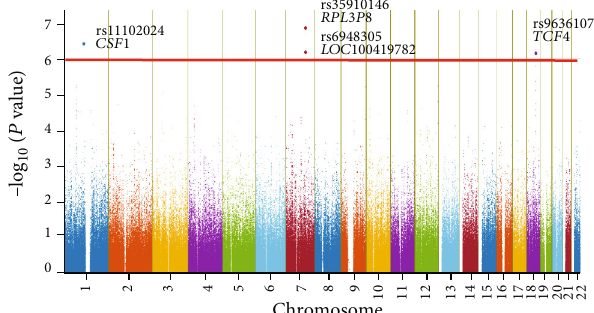
Figure 1: Genome-wide association scan for AOSD. Manhattan plot shows association between 645,983 SNPs and AOSD. Each dot represents a – log ( P value) derived with a logistic regression model 10 adjusted by sex and principal components (PCs) in 70 AOSD cases and 688 population controls. The red horizontal line marks the level of signi fi cance suggestive of association ( P < 1 × 10 -6 ). The top 4 AOSD-associated variants are labeled with the name of the nearest gene(s). CSF1 : colony-stimulating factor 1; RPL3P8 : ribosomal protein L3 pseudogene 8; LOC100419782 : pseudogene; TCF4 : transcription factor